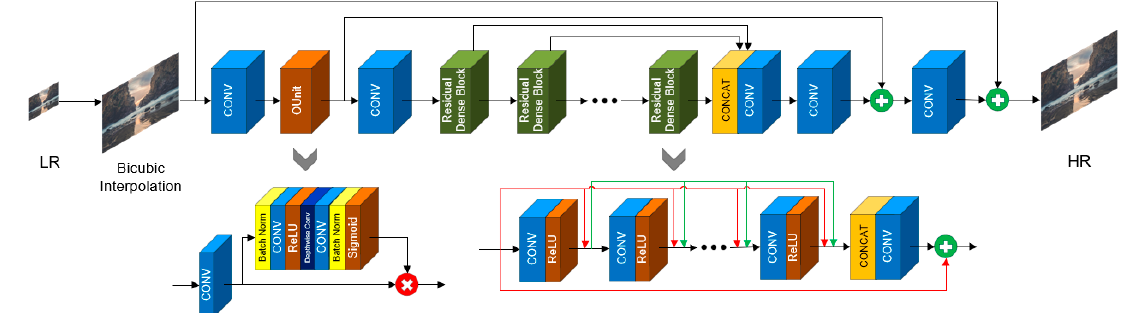
Figure 17. Dilated-RDN network structure (OUnit stands for optimized